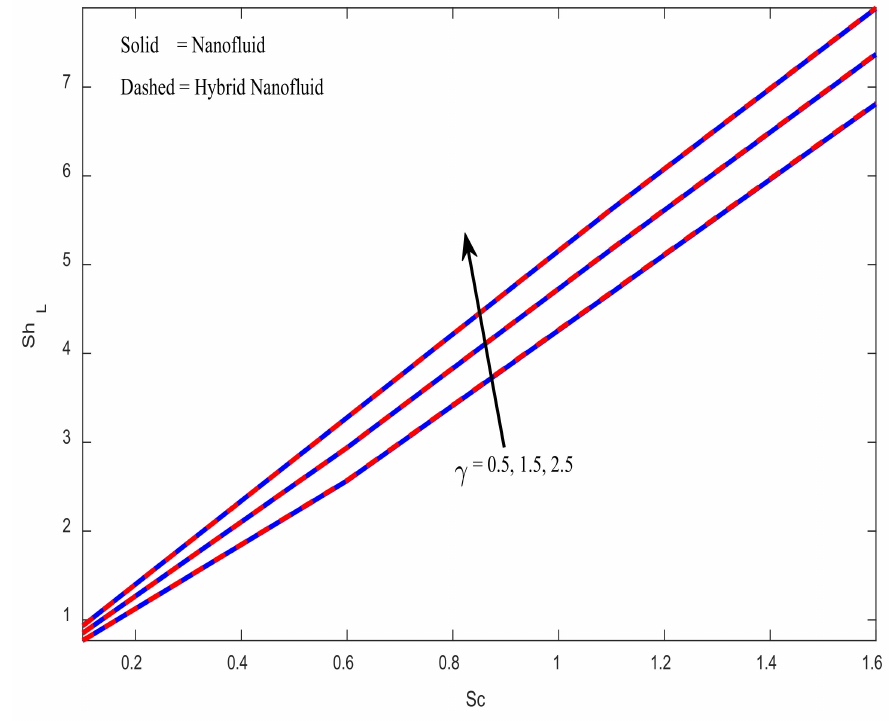
Figure 15. Influence of γ on Sherwood number near the lower